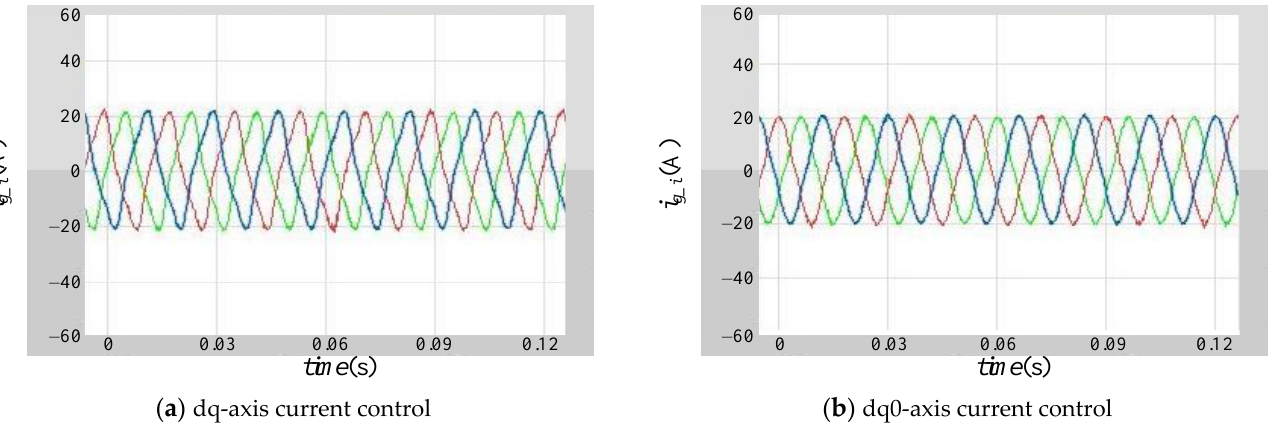
Figure 9. The output current of the current-controlled converter under different current control schemes when i dref is 20 A. ( a ) dq-axis current control; ( b ) dq0-axis current